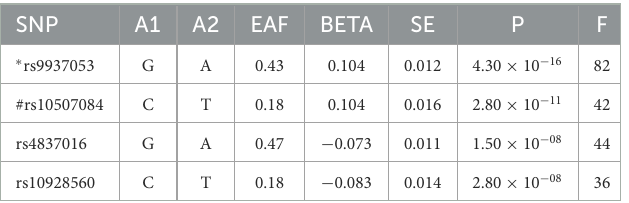
TABLE 1 Instrumental variables of obstructive sleep